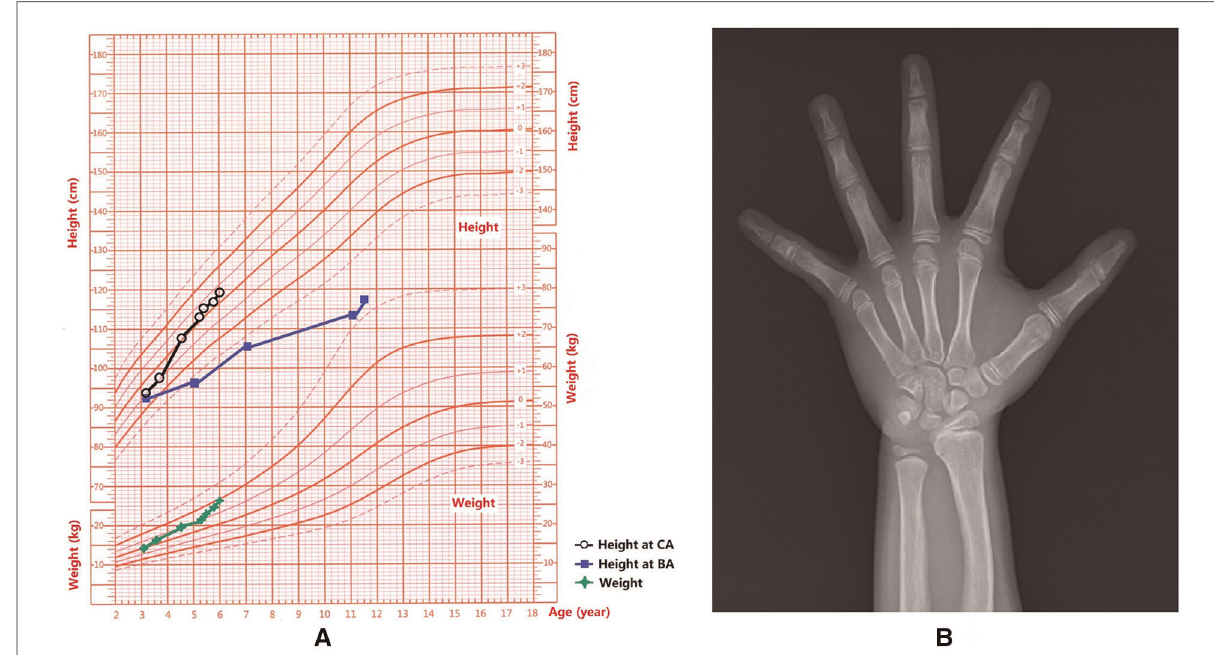
FIGURE 1 Growth and development data of this patient. ( A ) Weight and height for each age stage; Chronological age, CA; Bone age, BA. ( B ) The x -ray showed that the BA was 10.5 years old and there was a slight Madelung deformity when the patient was 5 years and 3 months